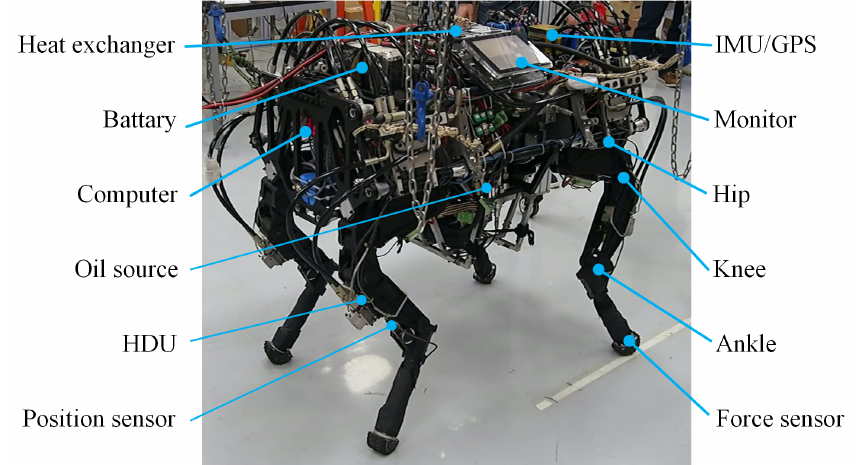
Figure 5. The overall structure of the electro-hydraulic quadruped platform, EHbot, with 12 hydraulically-actuated DoFs and various